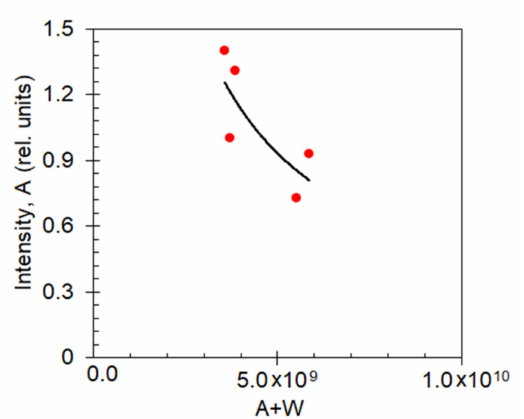
Figure 9. Maximal emission intensities (~ A ) plotted against the emission decay rates (A + W) measured in multiple local spots of the Au nanofoam sample at HITC concentration equal to n = 3.2 g / L. The solid line is the fit of the data points with the second order polynomial—guide for